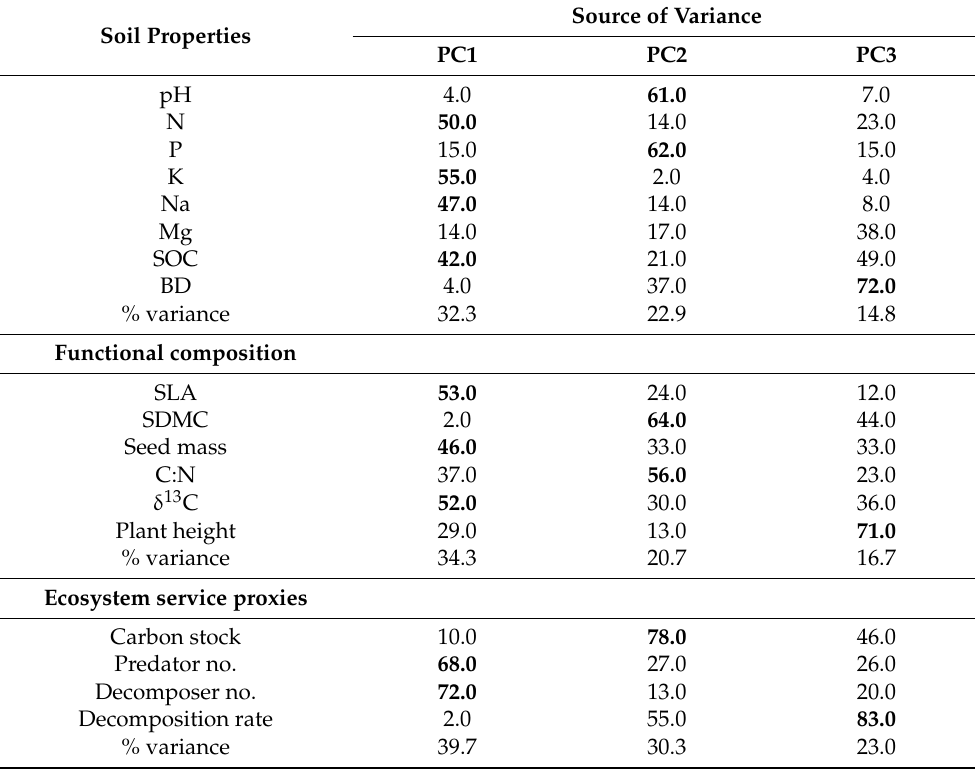
Table 2. Variance partitioning of trait attributes for the three ecosystem